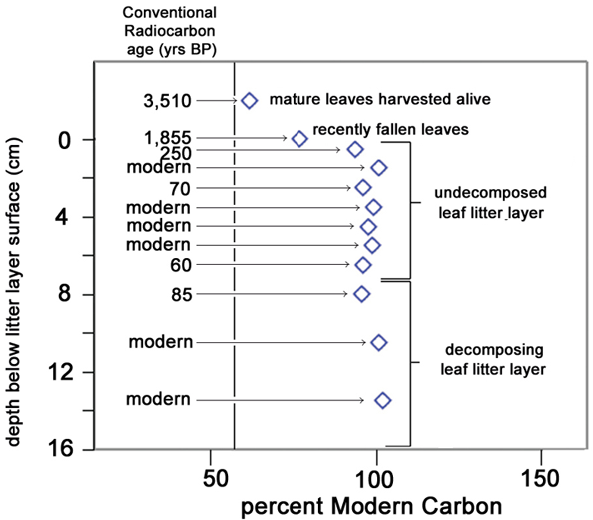
Fig. 1. Radiocarbon ages measured by the Australian Nuclear Sci- ence and Technology Organization AMS facility of PhytOC isolated from leaves of bamboo ( Bambusa vulgaris ‘Vittata’) and the under- lying litter layer (data from Sullivan et al.,